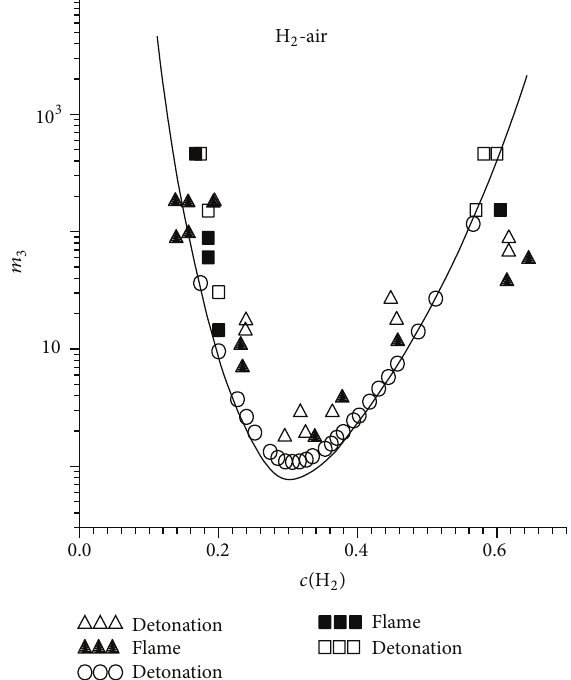
Figure 22: Correlation of experimental and calculated data about critical mass of TNT charge for initiation of spherical DW ([ 𝑚 3 ] = g) on fuel molar concentration of H 2 -air mixtures 𝑐 (H 2